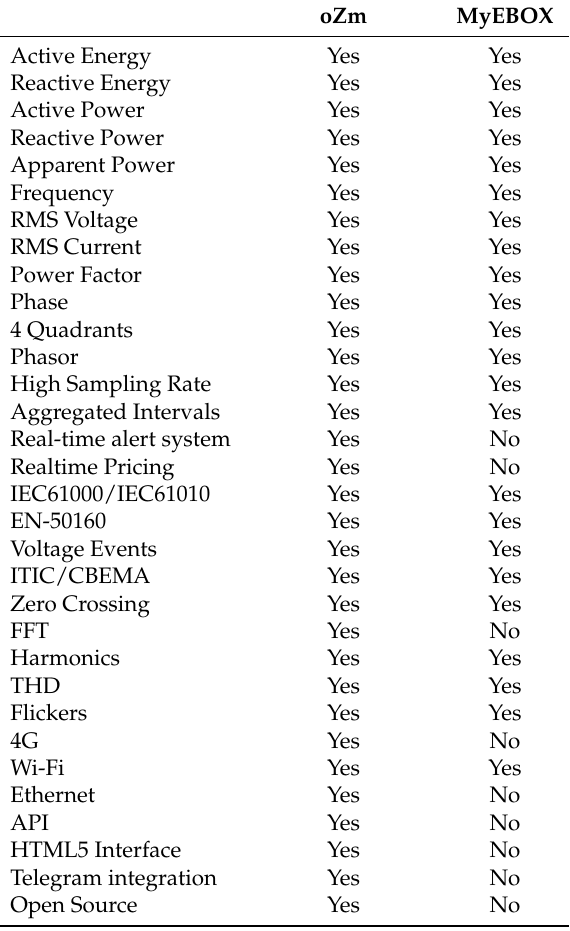
Table 2. List of main features of openZmeter (oZm) and